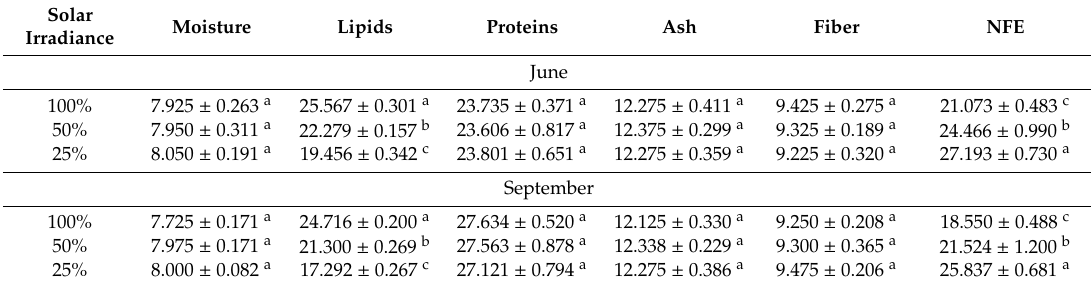
Table 2. Composition (%) of C. vulgaris cultivated during June and September in the greenhouse at 100%, 50%, and 25% of solar